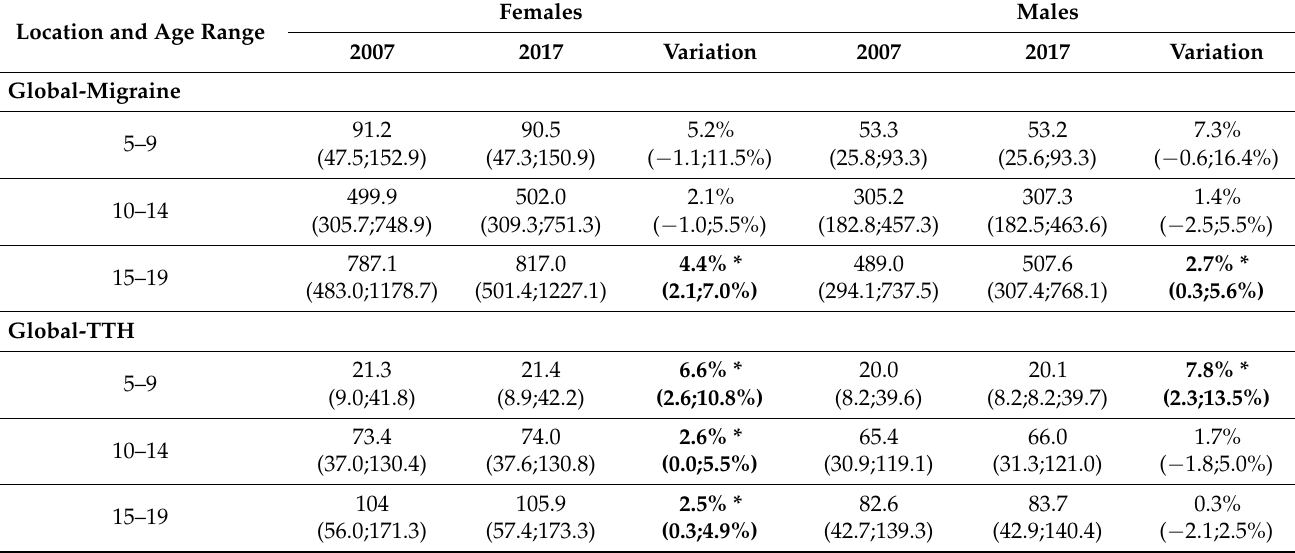
Figure 2. YLDs associated to migraine ( A ) and TTH ( B ) by gender and age group at global level. Estimates are reported in millions, with mean and 95% UI. Table 2. YLDs rates/100,000 for 2007 and 2017 and percentage variation, for migraine and TTH, by age and gender, at global level and by WHO